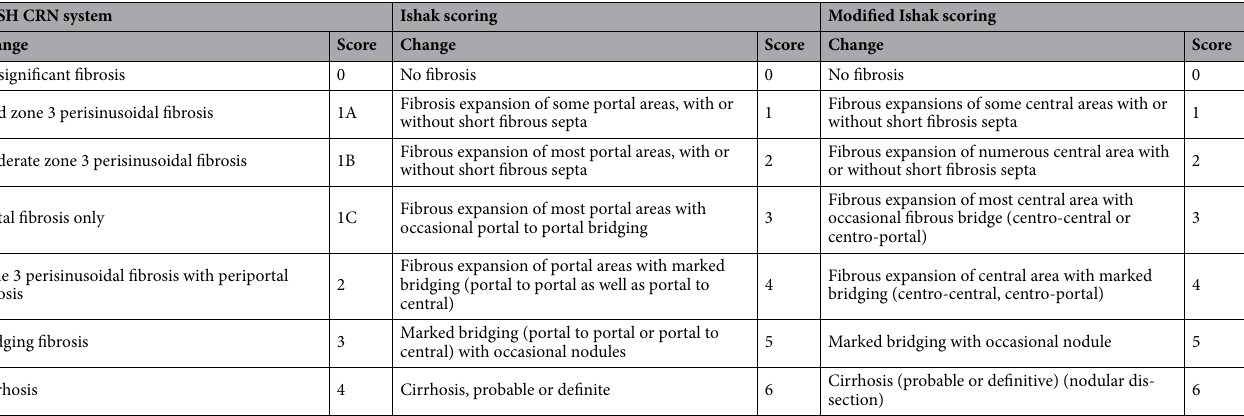
Table 1. Fibrosis scoring systems used in the present study. NASH clinical research network (NASH CRN), Ishak and modified Ishak scoring systems definitions and scores used in the present study for determining the severity of liver fibrosis in CCl 4 and HF-CDAA mouse models. NASH CRN scoring: from Kleiner et al., 2005 10 ; Ishak scoring: from Ishak et al., 1995 9 .